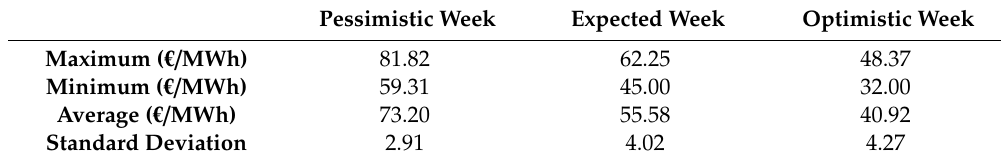
Table 1. Details of the weeks chosen to help in the scenario generation.